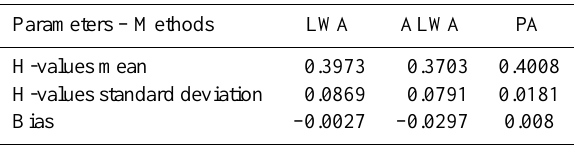
Table 2. Statistical parameters of the obtained Hurst values corre- sponding to Fig. 1.